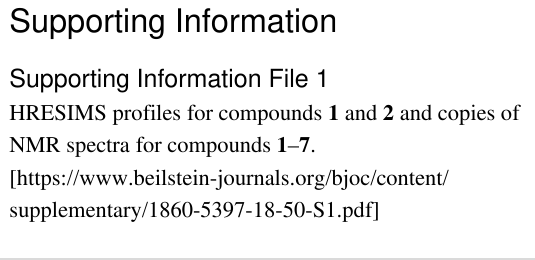
Table 1; HRMS–ESI ( m / z ): [M + Na] + calcd for C 15 H 22 O 6 Na, 321.1309; found,